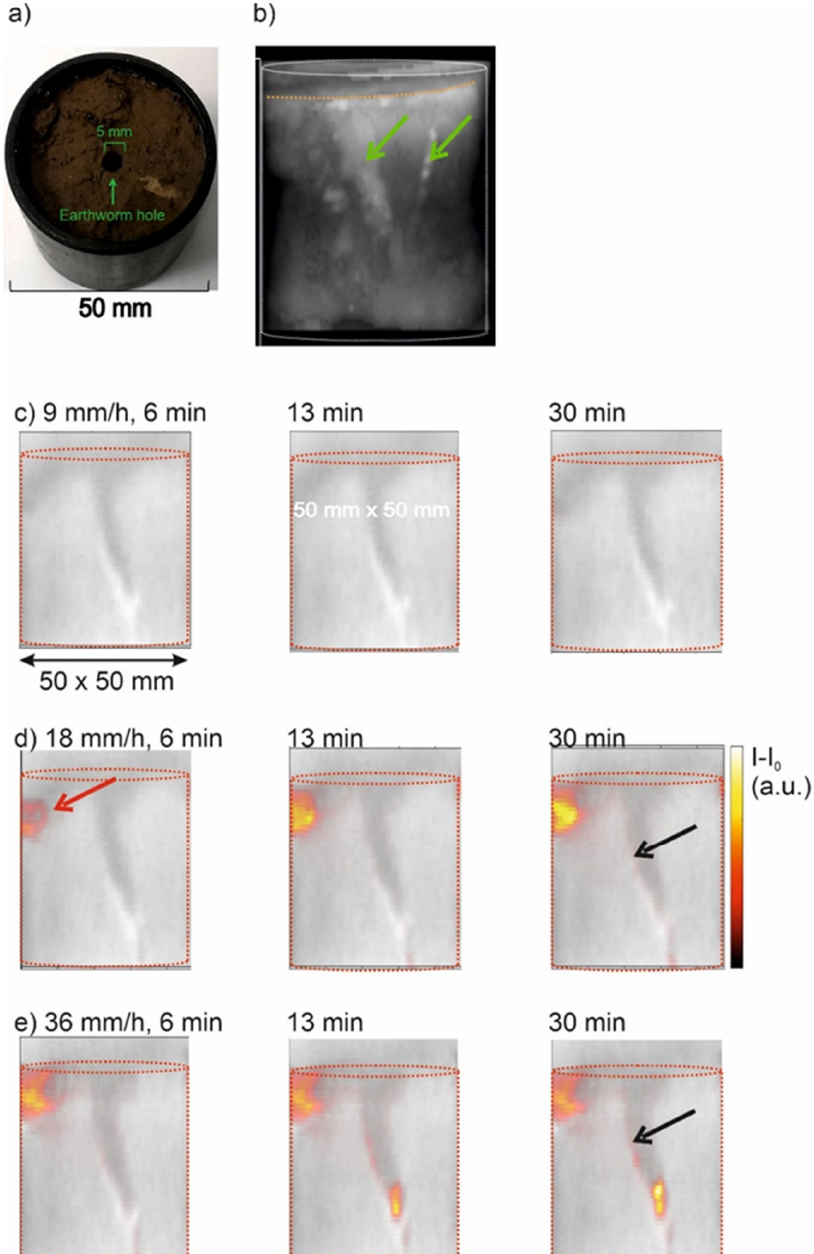
Figure 6. Imaging flow in a natural soil core during irrigation. ( a ) Setup. ( b ) ZTE image of the natural core (maximum intensity projection) with no irrigation. Matrix size 128 3 , FOV: 70 × 70 × 90 mm. The dotted orange line indicates the soil surface, the green arrows point to the large wormhole and a smaller macropore, probably caused by a degraded root. ( c – e ) Central vertical slice with different irrigation rates (top to bottom) and time-points after start (left to right). Shown are difference images at the given time-points minus t = 0. The red arrow indicates ponding water near the left edge. The black arrows indicate film flow at the walls of the large wormhole.